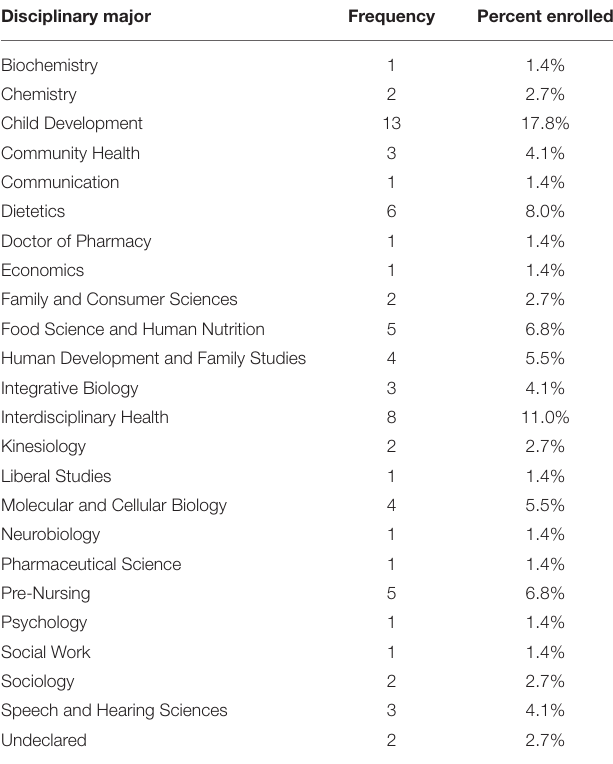
TABLE 1 | Students’ disciplinary